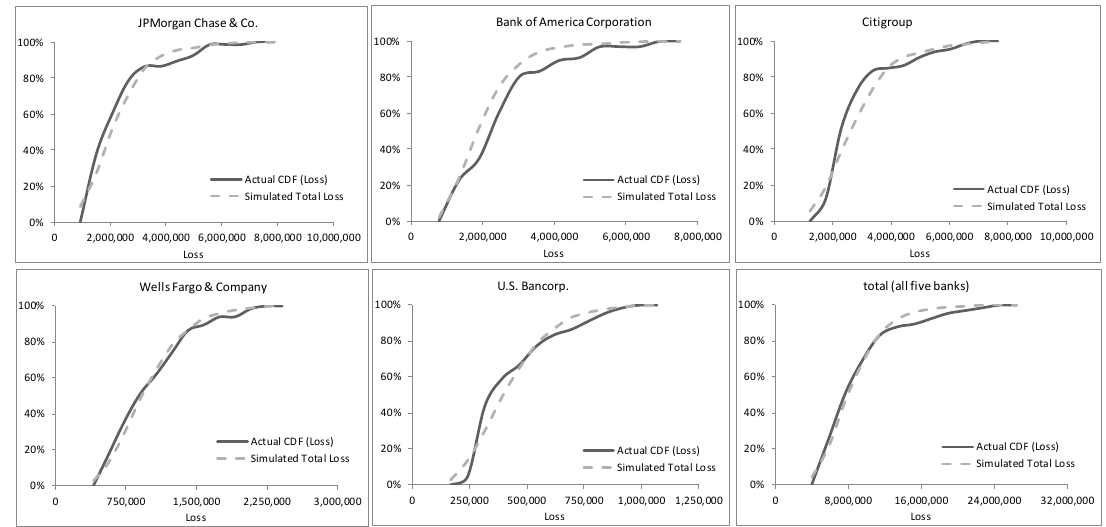
Table 7. Kolmogorov–Smirnov test results. Figure 9. Distribution functions of overall losses. Figure 9. Distribution functions of overall losses.